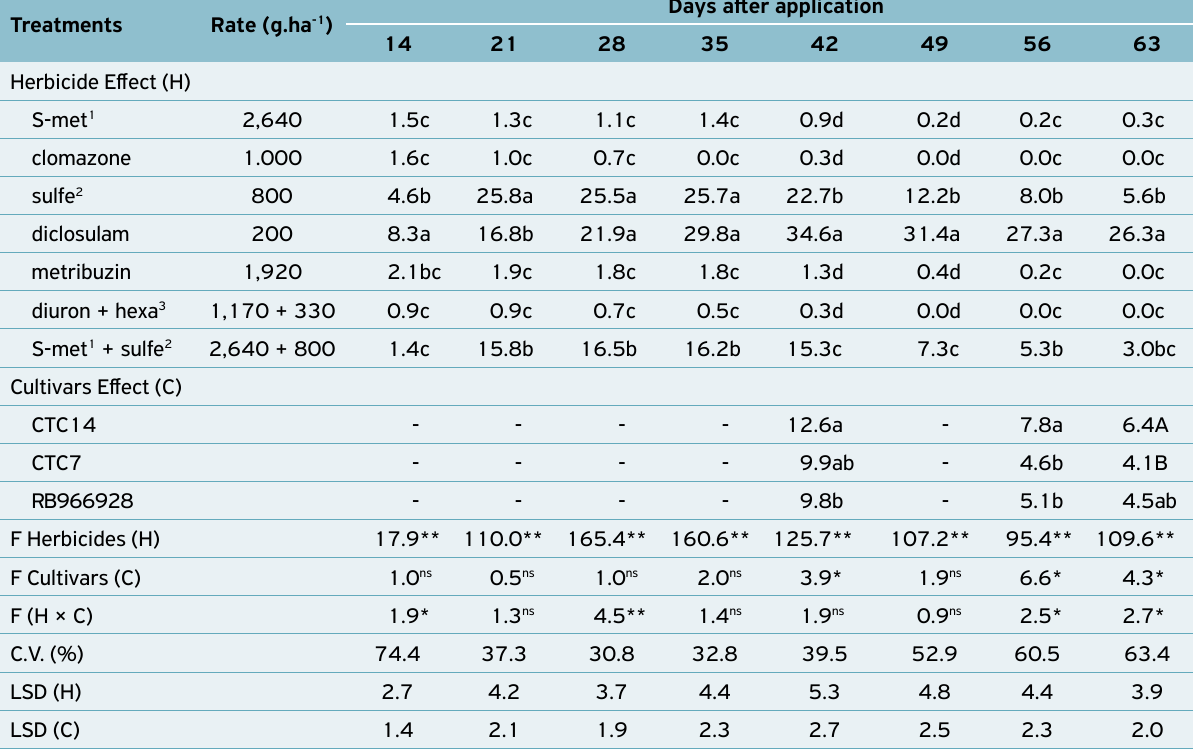
Table 1. Percent mean values of intoxication caused by different herbicides applied in pre-planting to three sugar cane cultivars. Pradópolis, state of São Paulo, Brazil,